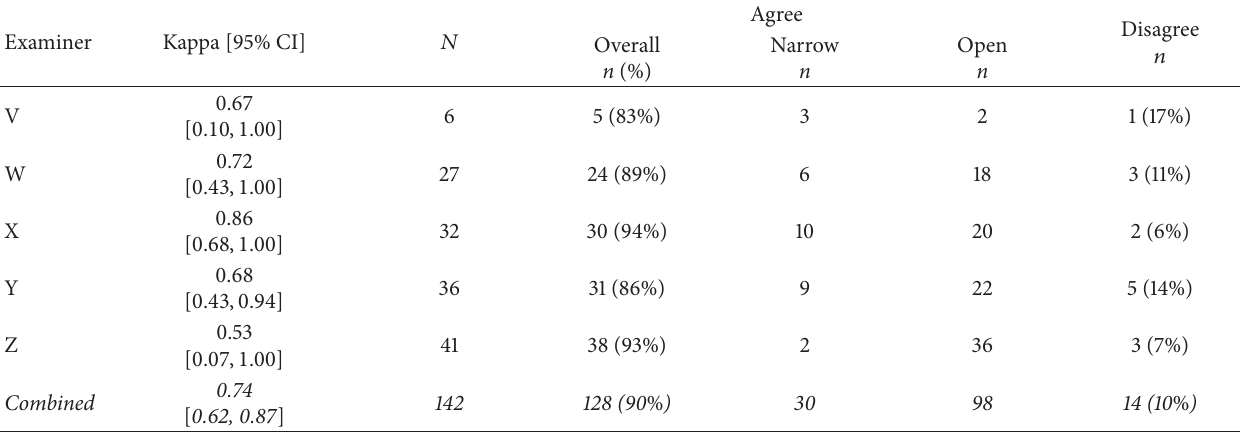
Table 3: Gonioscopic intraobserver (intervisit) agreement for angle classification by examiner (kappa [95% confidence interval]). Examiner